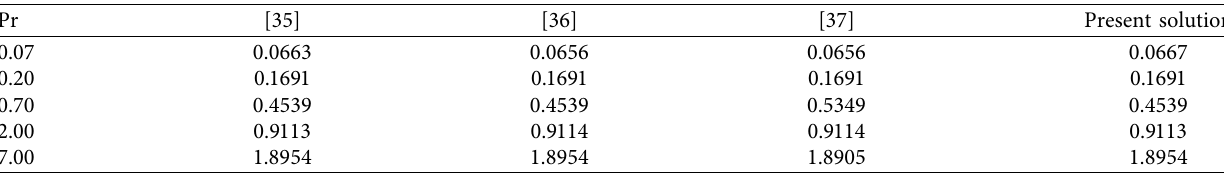
′ ( 0 ) for ε � β � Κ � M � c E � λ � Sr � Df � Nt � Nb � 0 .